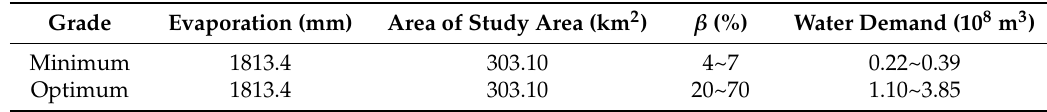
Table 2. Water demand for evaporation.